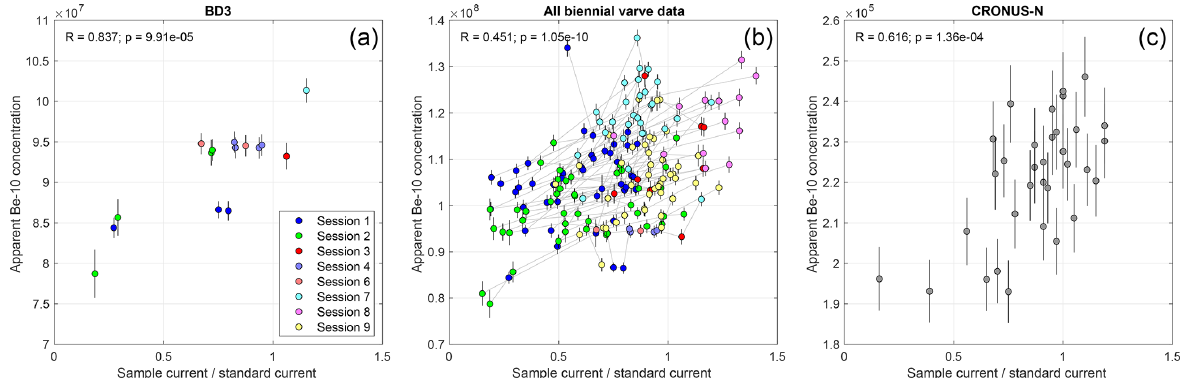
Figure 5. Observed relation between 9 Be beam current relative to standards and the measured 10 Be / 9 Be ratio, here expressed as the nuclide concentration instead of the ratio to account for small differences (ca. 5%) in sample and Be carrier masses between replicate analyses (see text). (a) 15 replicate analyses of the BD3 sample (see text). (b) Replicate analyses of samples from 80-year biennial records at the KF and NHV sites (see text above); each of these samples was measured at least twice, and light-colored lines connect replicate analyses. Note that true 10 Be concentrations vary among samples in this data set, but a significant correlation with beam current is present regardless, and nearly all replicates of individual samples display a positive slope in this diagram. In the left-hand two panels, symbol color-coding indicates the AMS measurement session in which each analysis took place. Sessions 1–2 were measured in 2012, 3–5 in 2013, and 6–9 in 2014. (c) Equivalent data for in-situ-produced 10 Be in the CRONUS-N quartz standard (Jull et al., 2015) prepared in the UVM chemistry lab and measured on the SUERC accelerator between 2013 and 2017, as reported by Bierman et al. (2017).